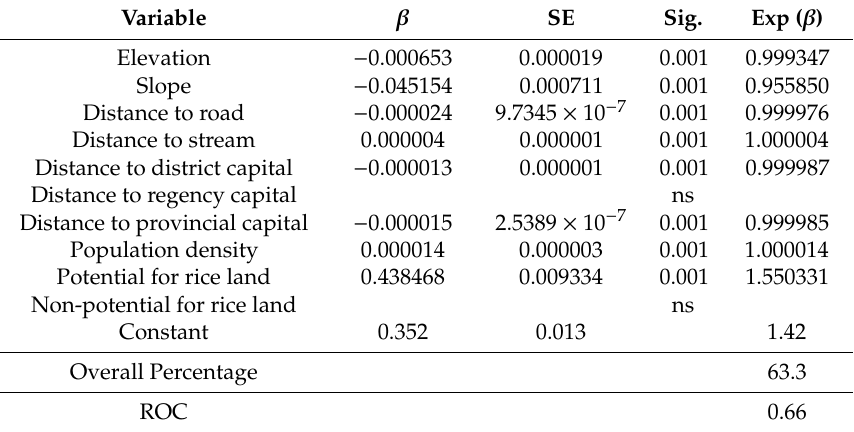
Table 8. Binary logistic regression of the probability of rice land conversion 2009 to 2018.